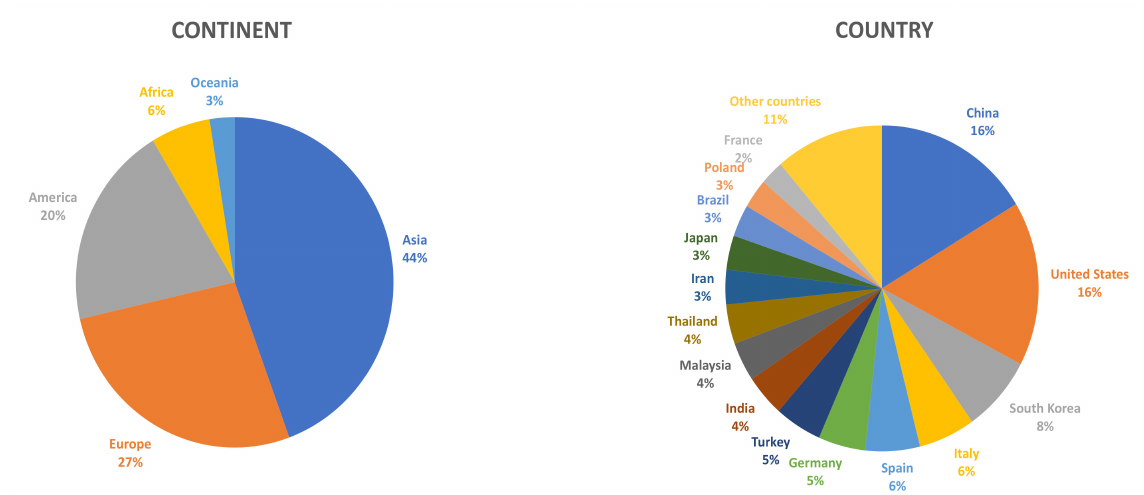
Figure 1. Percent distribution of scientific articles on fruit vinegar published from 2015 to 2020, according to the origin of the research groups (continent/country) (Source: